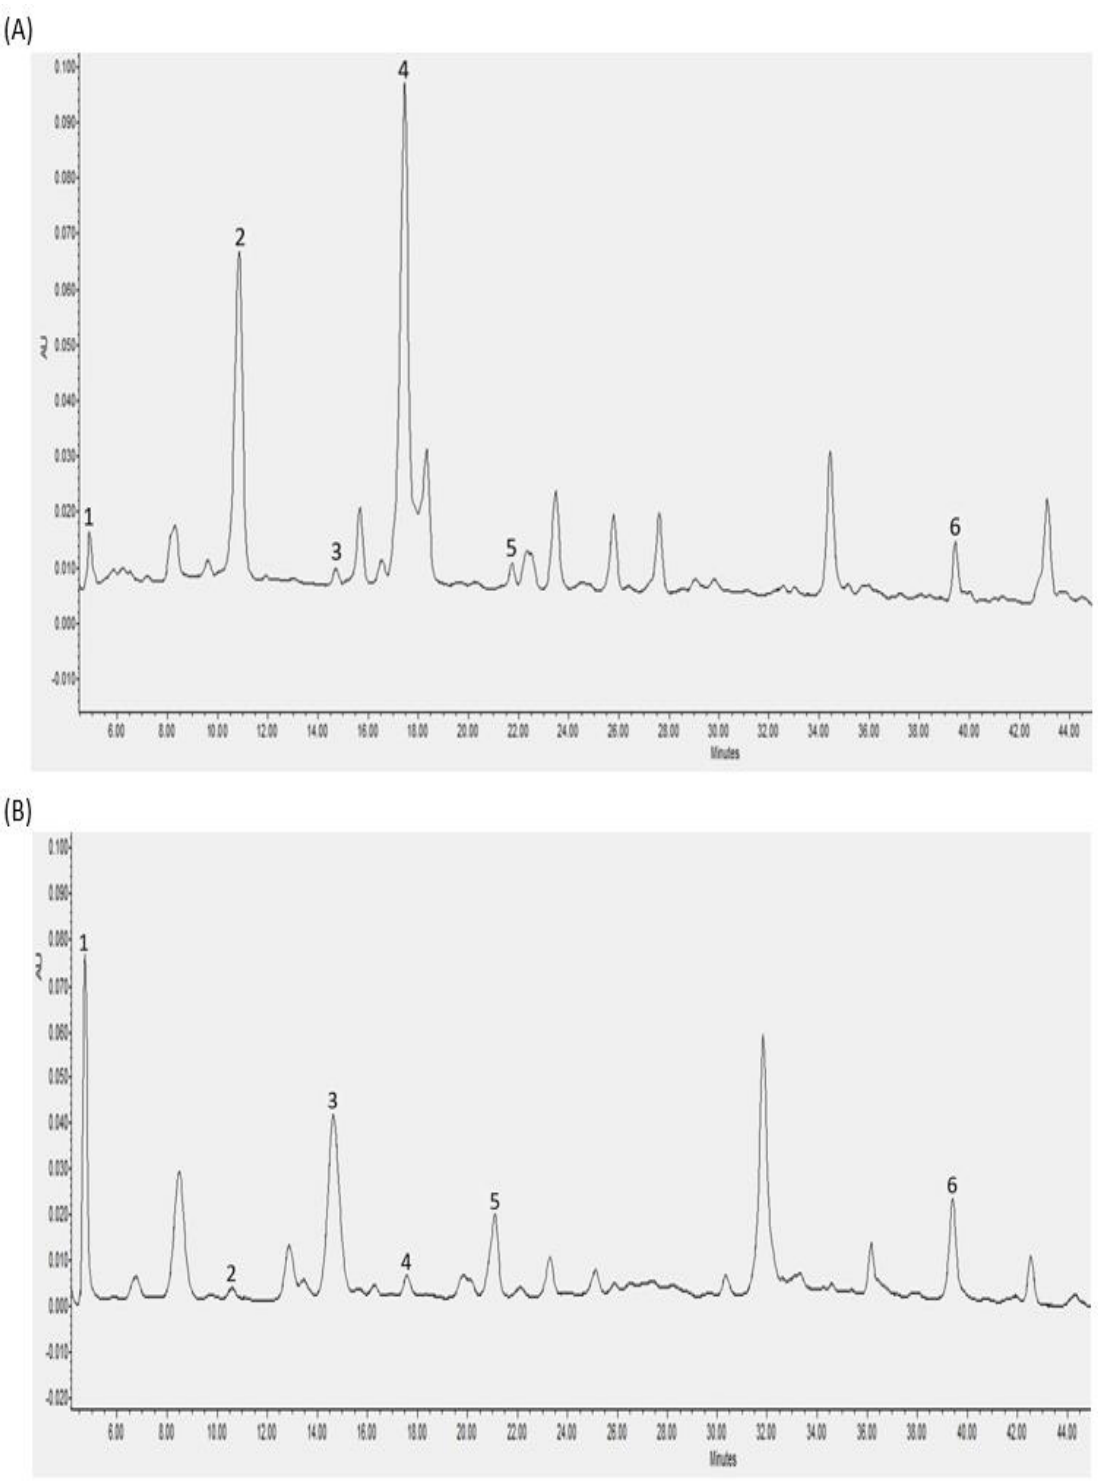
Figure 2. HPLC chromatograms of gastrointestinal fractions of chicory; ( A ) Soluble gastric fraction (extracted from supernatant), ( B ) Soluble intestinal fraction (extracted from supernatant). Polyphe- nols identified are (1) Gallic acid, (2) Protocatechuic acid, (3) Catechin, (4) p -hydroxybenzoic acid, (5) Epicatechin, and (6) Quercetin-3-rhamnoside.